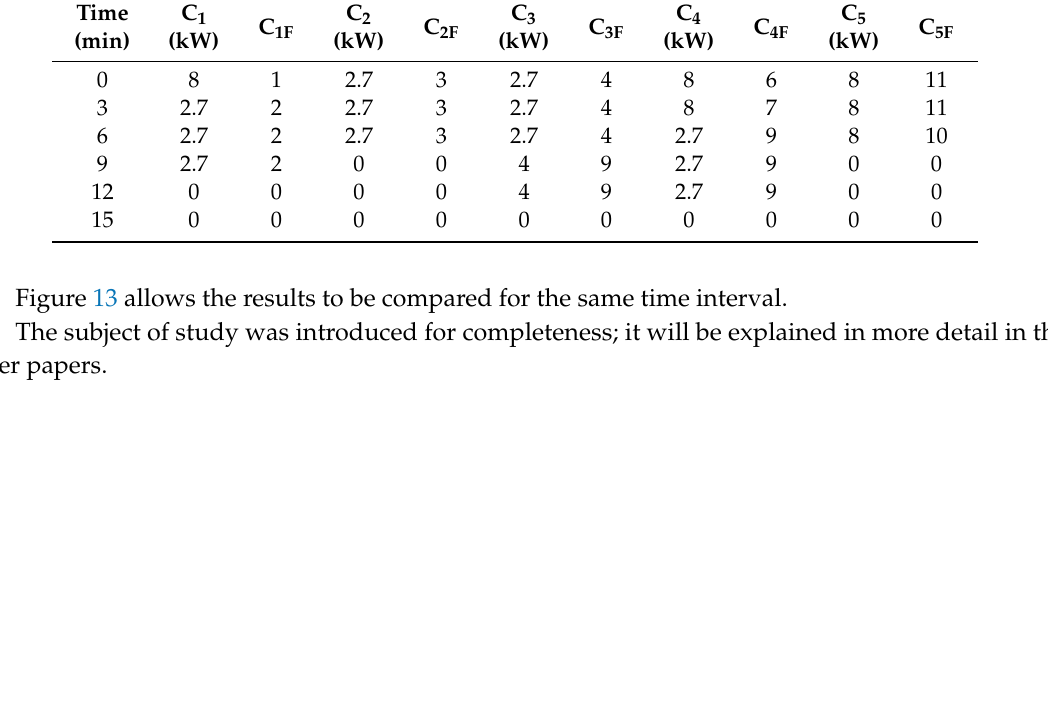
Table 6 indicates a possible solution with three recharge thresholds. Table 6. Management with three recharge thresholds, P = 2.7,4, and 8 KW.